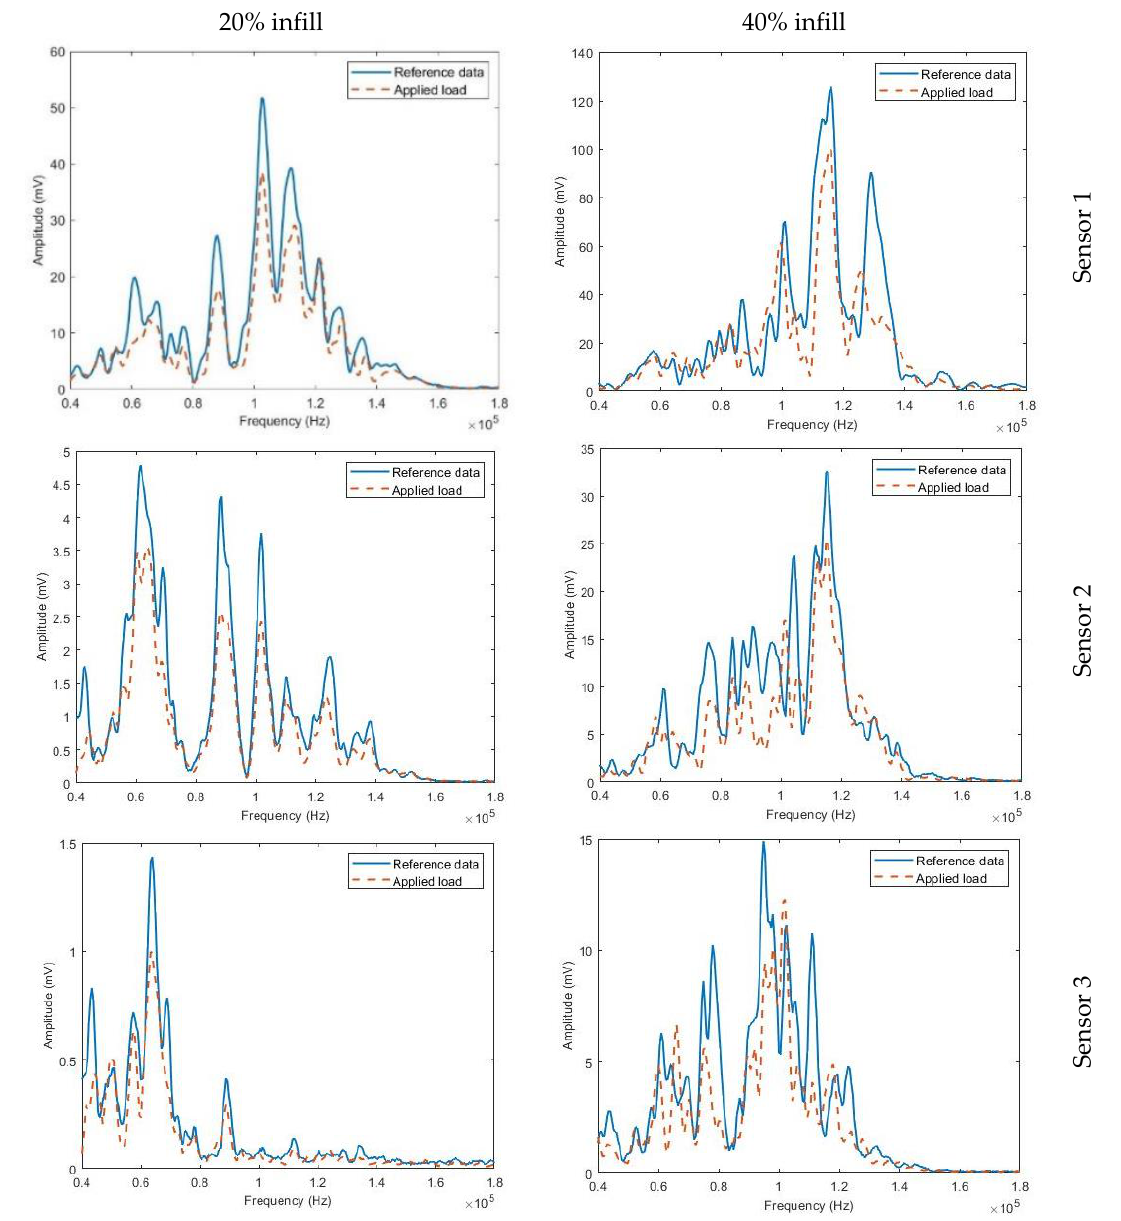
Figure 6. Spectrums of the sensors for baseline and loaded cases when the beams had low infill density. The number of the local peaks in the spectrums increases with distance from the exciter. It can be seen that the changes in the loading condition are evident in the monitored signal of all the sensors. The same experiment was performed for beams with 60%, and 100% infill ratios and results are presented in Figure 7. The changes in the spectrums are generally higher for the part with 60% infill. The sum of squares of the differences (SSD) for all beams with different infill densities are calculated and shown in Figure 8. The generated surface waves traveling along the beam lose more energy when the